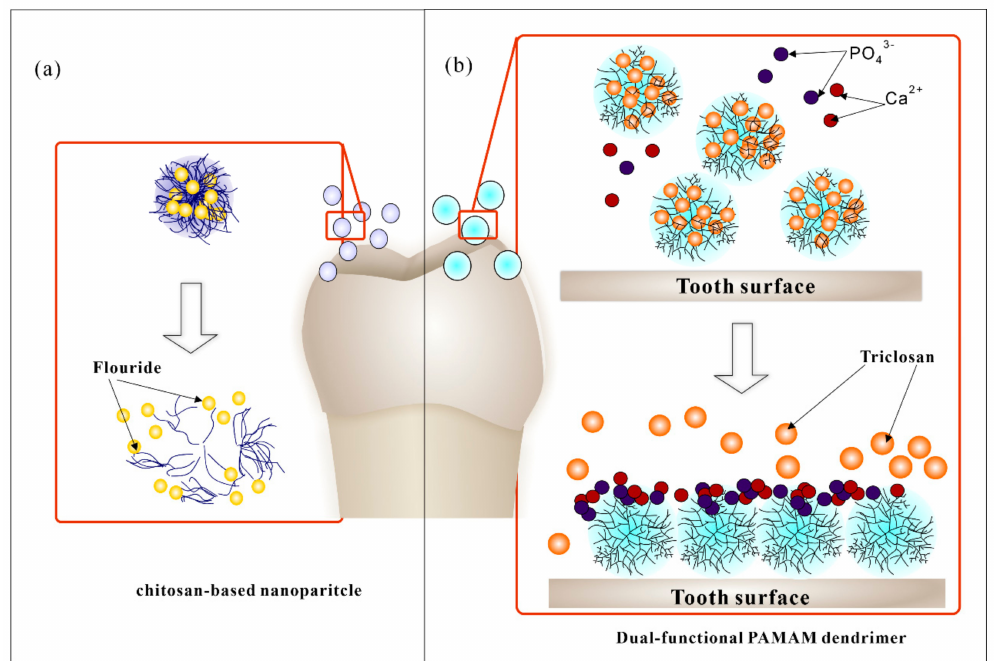
Figure 3. Recent remineralizing DDS for dental caries. ( a ) Flouride loaded chitosan-based nanoparticles; ( b ) Triclosan-loaded PAMAM dendrimer. The dual functional DDS showed anti-bacterial e ff ect and dental remineralization as well. Triclosan is an anti-bacterial agent while PAMAM dendrimers could aggregate into a microribbon structure and promote dental